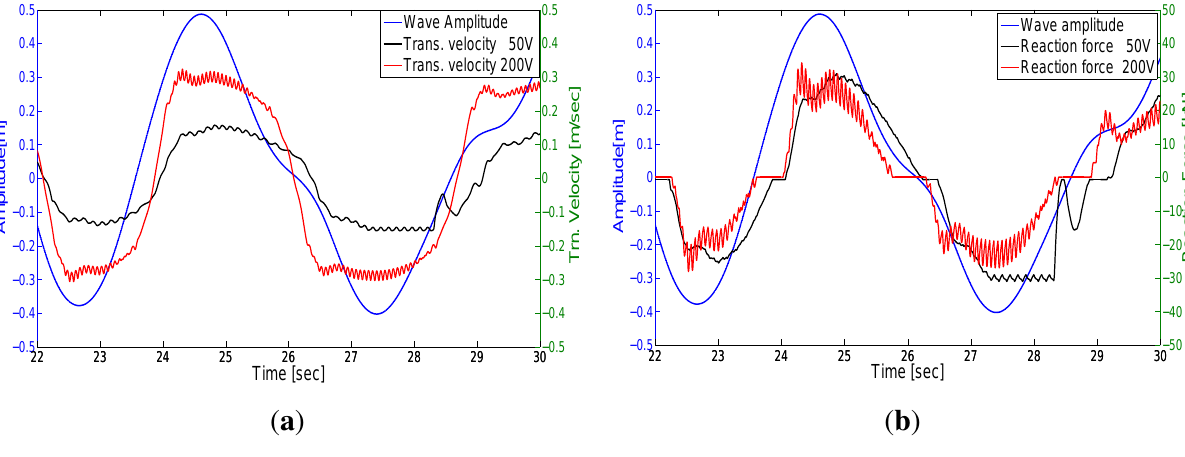
Figure 3. Examples of WEC velocity and damping force, using a constant DC-link at 50 V and 200 V. ( a ) Comparison of translator velocities; ( b ) Comparison of Reaction